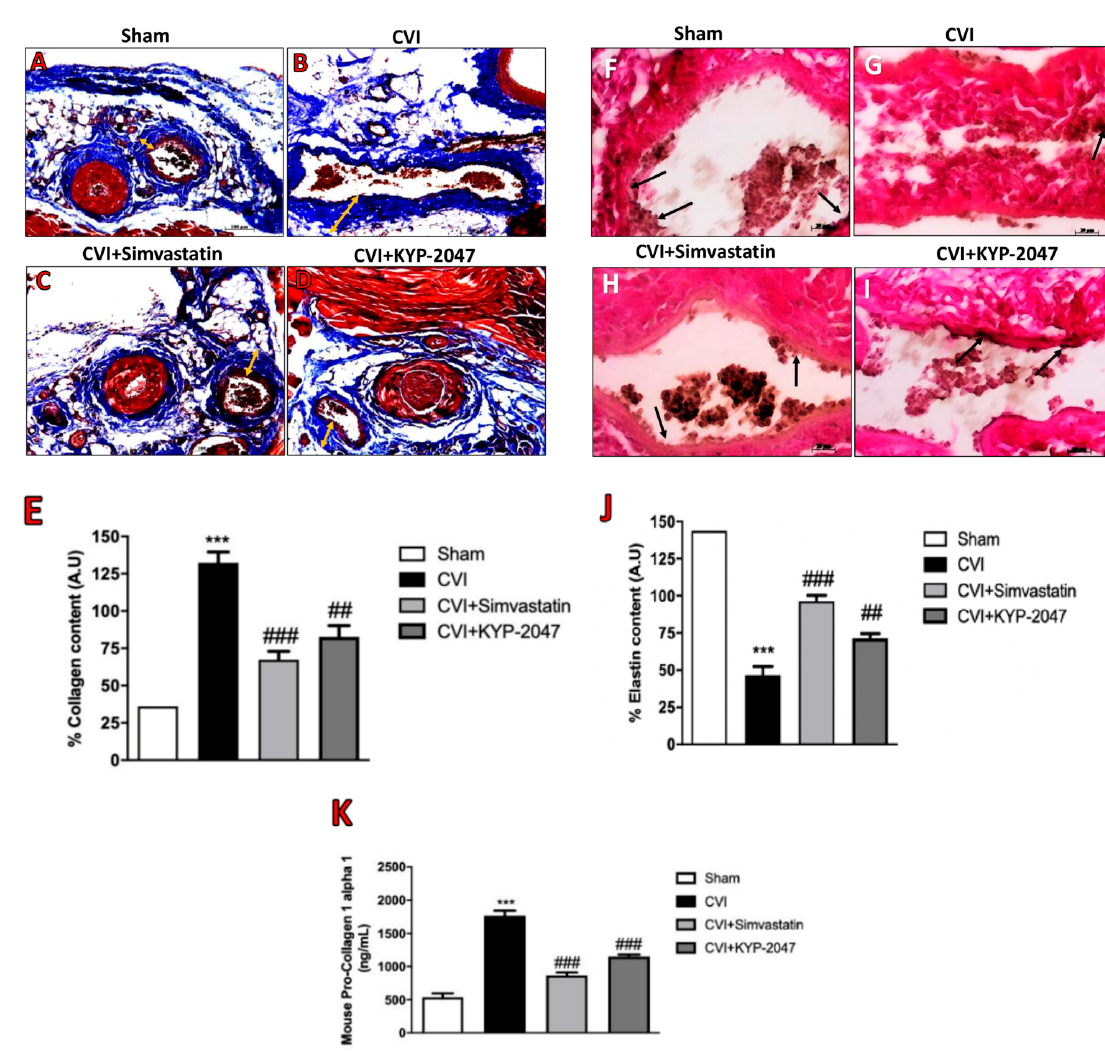
Figure 6. Treatment with KYP-2047 in the collagen content reduction and elastin increase. The degree of fibrosis, in CVI-provoked lesions, 7 days post-saphene vein ligation, was assessed by Masson trichrome staining and Van Gieson staining, revealing a fibrotic area stained blue larger than in control group ( B ), see collagen content score ( E ); ( A ), see collagen content score ( E ) and a reduced elastin content highlighted in red purple ( G ), see elastin content score ( J ); ( F ), see elastin content score ( J ). Treatment with KYP-2047 significantly reduced collagen depot, located in the tunica adventitia ( D ), see collagen content score ( E ) and increased the content of elastin fibers ( I ), see collagen content score ( J ) almost similarly to Simvastatin treatment (respectively ( C ), see collagen content score ( E ), ( H ), see elastin content score ( J ). Pro-collagen 1 levels were detected by ELISA kit, confirm the results observed by Masson trichrome staining ( K ). Orange arrows identified collagen content, while black arrows identified elastin content. Scale bar for figures A–D: 100 µm, magnification 10 ×. Scale bar for figures F–I: 20 µm, magnification 40 ×. Data represent the means of at least three independent experiments. One-way ANOVA followed by Bonferroni post-hoc. *** p < 0.001 versus Sham; ## p < 0.01 and ### p < 0.001 versus CVI. 3.7. Role of KYP-2047 Treatment in Preventing Mast Cell Degranulation Increased infiltration of activated mast cells has been recently implicated in the pathophysiology of varicose veins [46]; mast cells produce and release various kinds of vasoactive substance, including histamine,